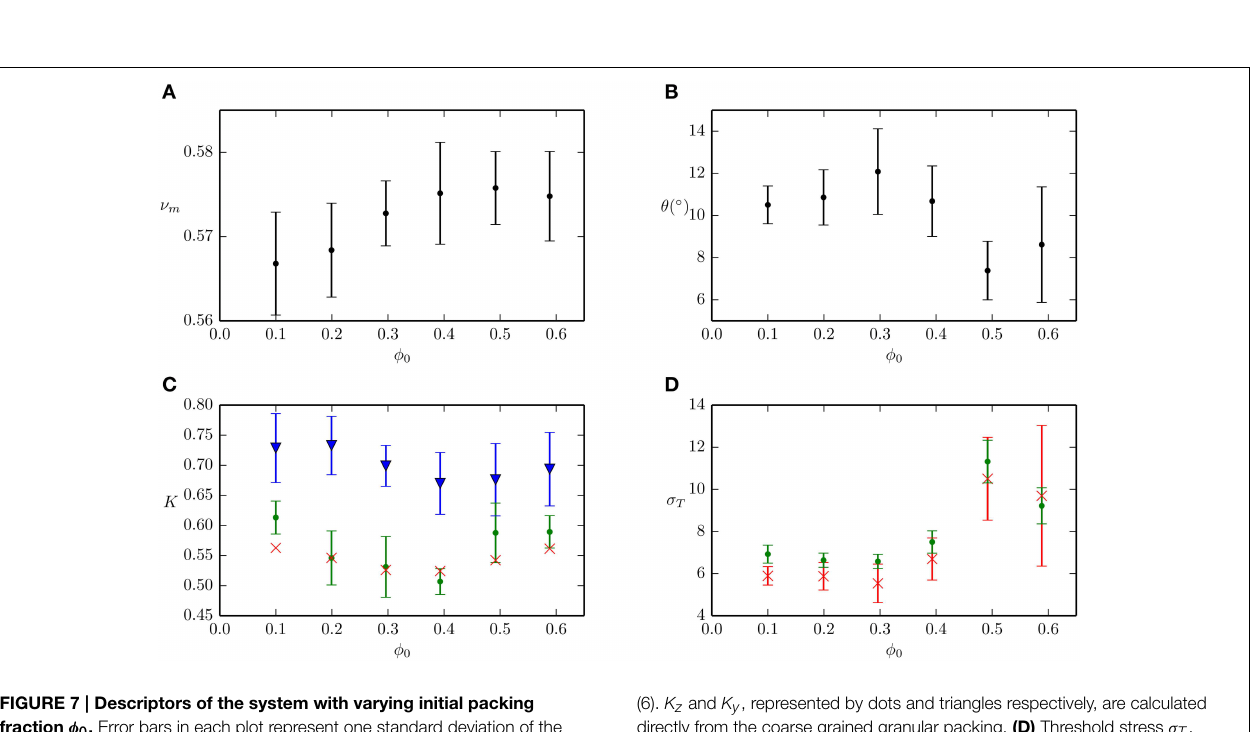
FIGURE 6 | Descriptors of the system with varying gap spacing D . Error bars in each plot represent one standard deviation of the measured value. (A) Average solid fraction within the plug zone, ν m . (B) Slope of the pile in the transition zone, θ . (C) Crosses represent best fit value of K z from measurement of the stress on the piston head, σ p n using Equation (6). K z and